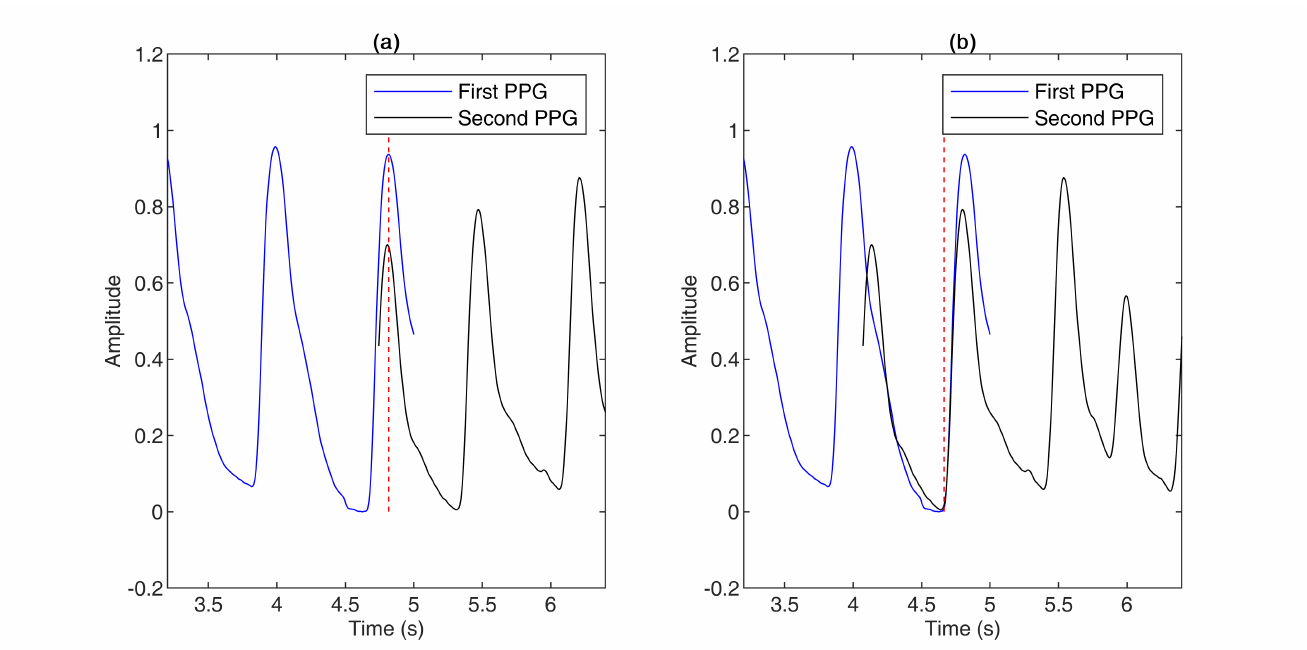
Figure 3. Comparison of stitching two PPG signals together based on the systolic peak or based on the onset. ( a ) First and second PPGs aligned based on the systolic peak. ( b ) First and second PPGs aligned based on the onset. The red dotted lines in ( a , b ) are the aligned lines of the first and second